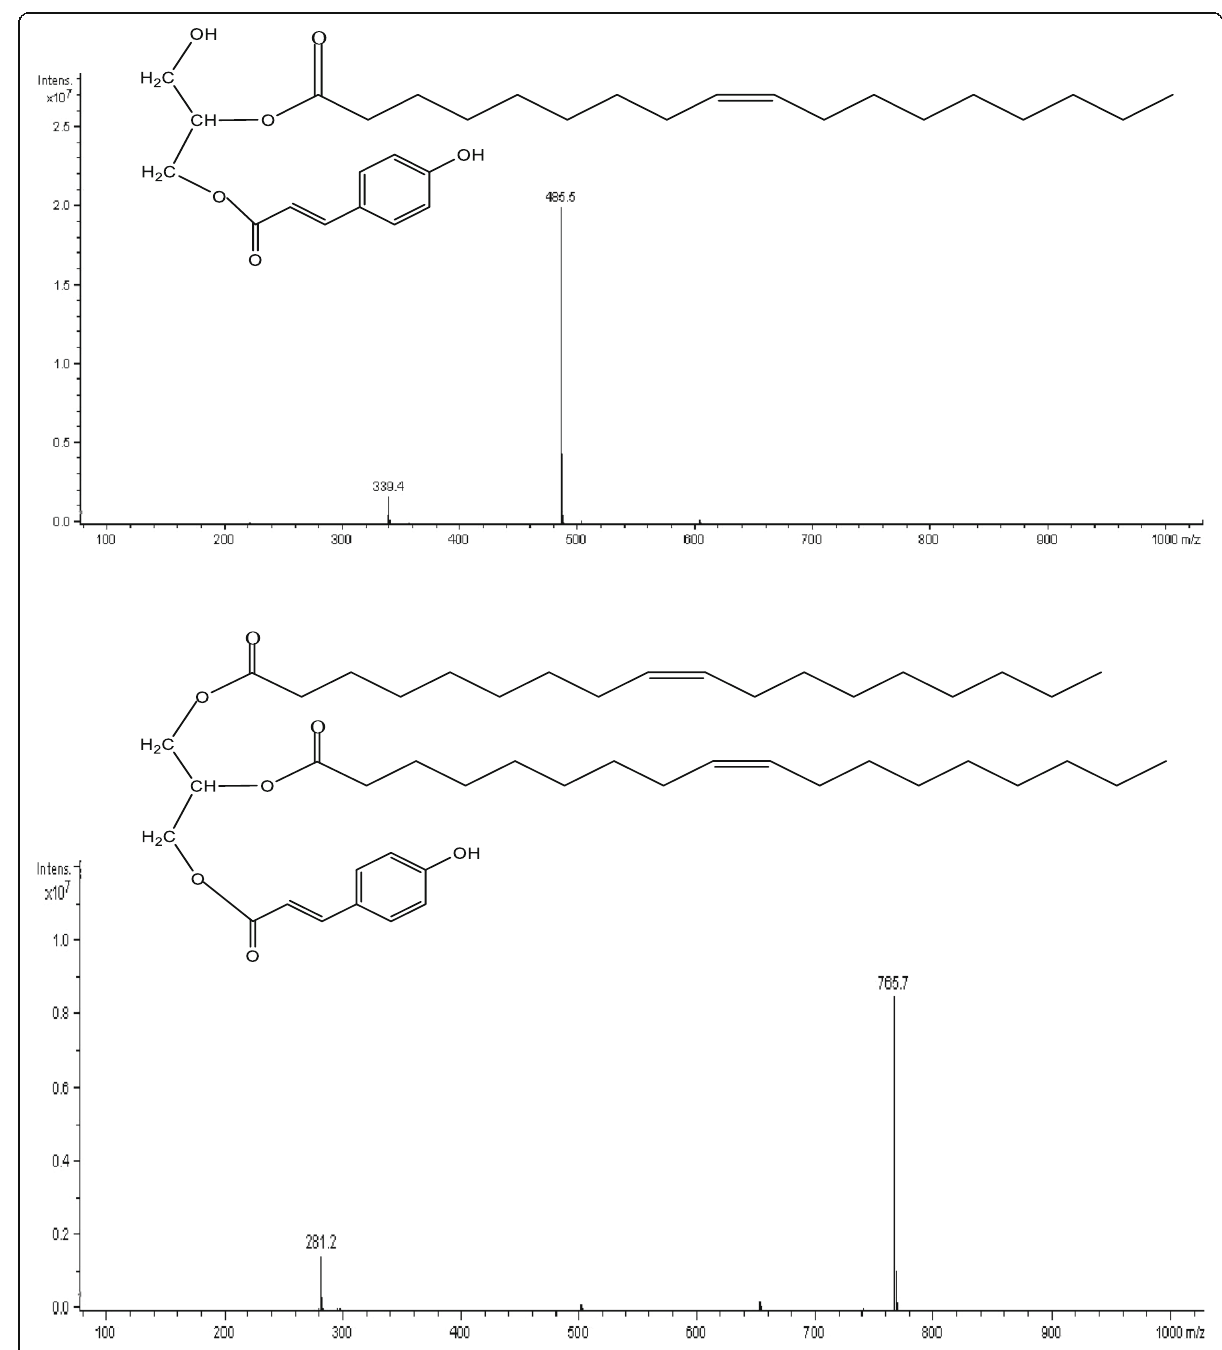
Fig. 3 Chemical structures and mass spectrometric data of monooleyl p -coumarate (top) and dioleyl p -coumarate